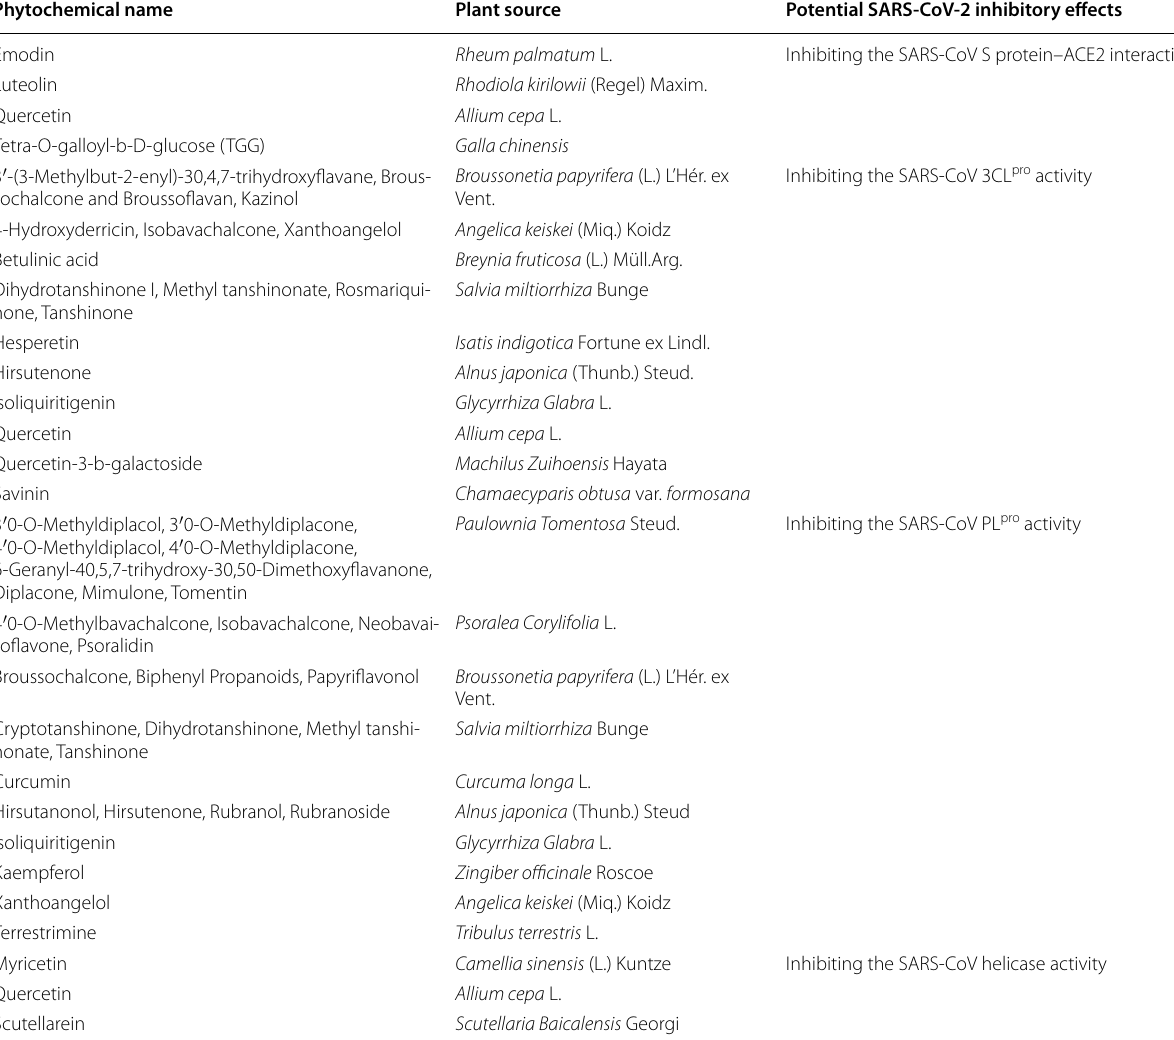
Table 1 A list of phytochemicals reported for potential SARS-CoV-2 inhibitory properties (compiled from